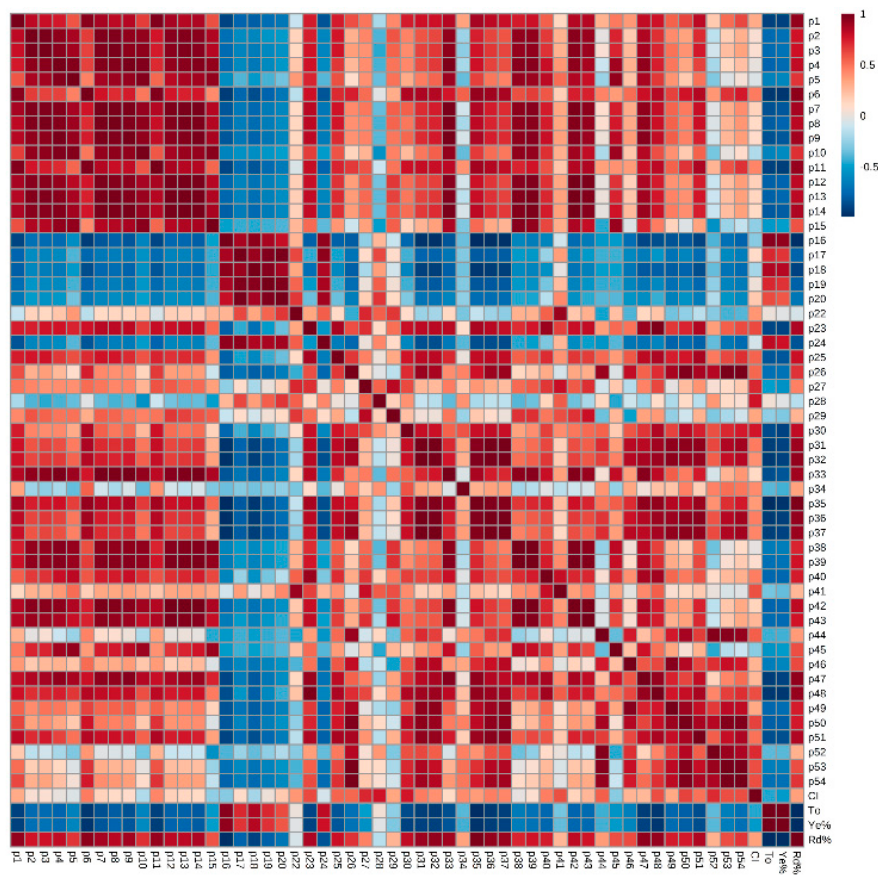
Figure 4. Pearson correlation analysis between phenolic compounds and color parameters.